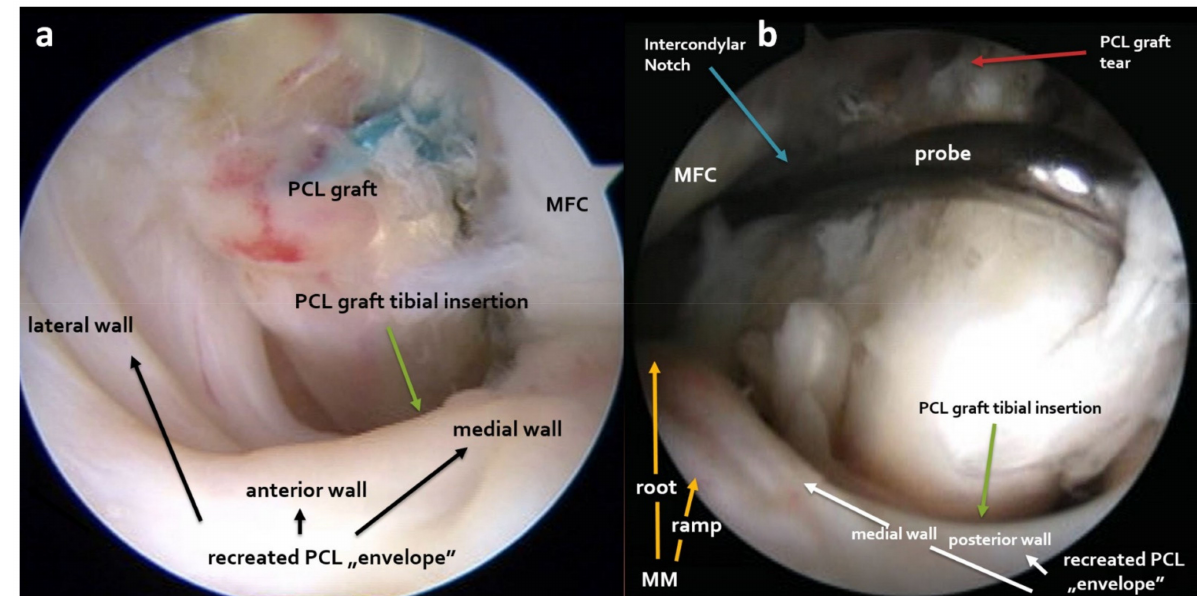
Figure 3. ( a ) Arthroscopic view from an anterolateral portal in a right knee joint after a PCL reconstruction. Trans-notch maneuver. The recreated PCL “envelope” can be observed between PCL graft and tibia. ( b ) Arthroscopic view from a posteromedial portal in a right knee joint after a PCL reconstruction. The recreated PCL envelope can be observed in the knee with a posttraumatic PCL graft tear. The probe is inserted through the anterolateral portal and intercondylar notch. MFC—medial femoral condyle, MM—medial